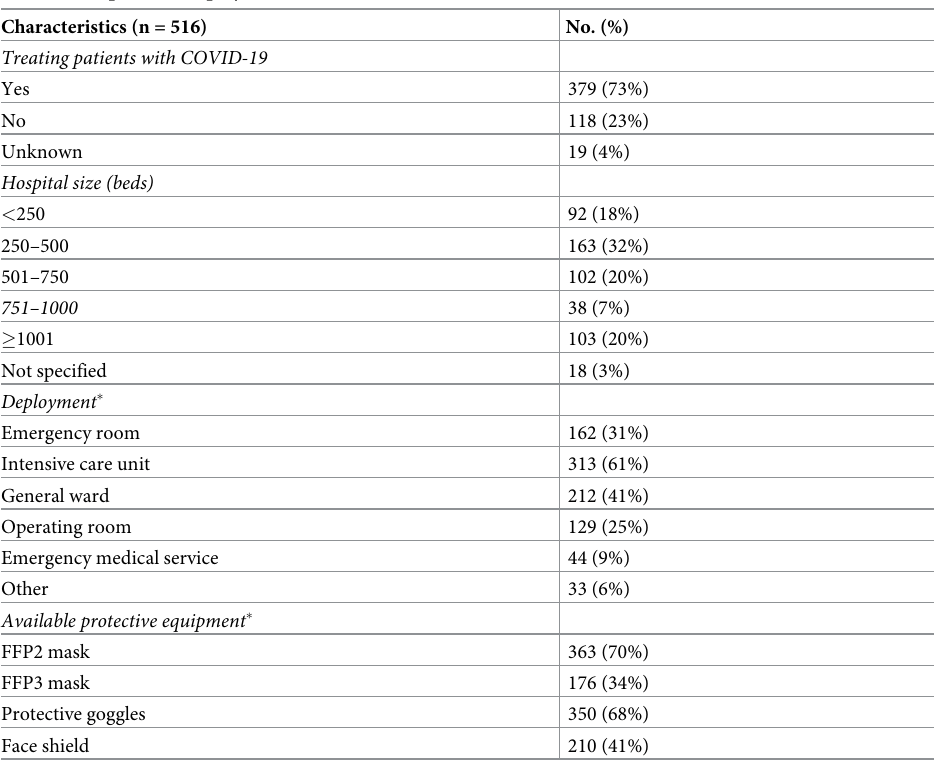
Table 2. Hospital and deployment